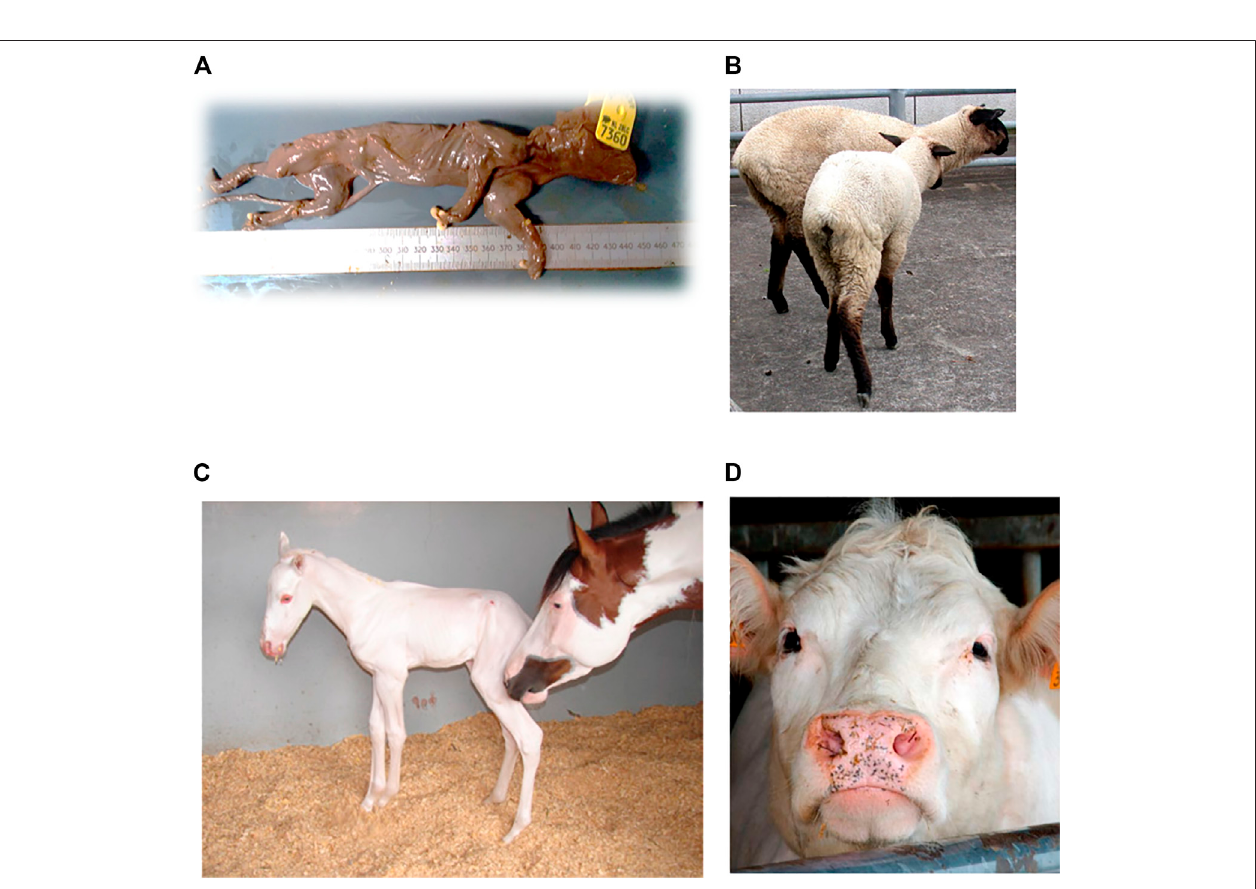
FIGURE 3 | Examples of (A) Mummi fi ed piglet resulting from a large deletion in pigs, fi gure from (Derks et al., 2018). (B) Ovine hereditary chondrodysplasia, also known as the Spider Lamb Syndrome, fi gure from (Thompson et al., 2008) (C) Lethal white foal syndrome, fi gure from (Ayala-Valdovinos et al., 2016) (D) White heifer disease, fi gure from (de Meuter,